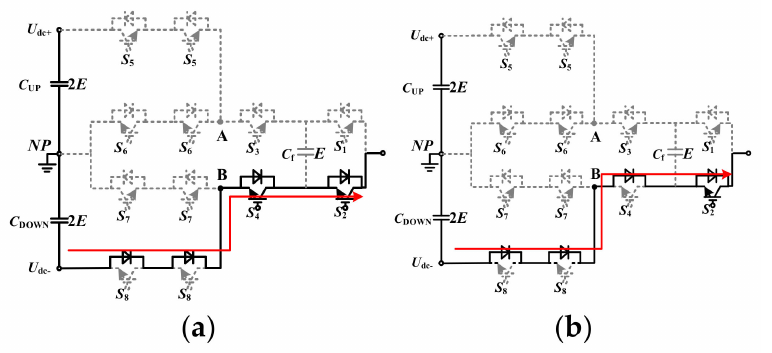
Figure 8. Conduction path of S3 and S4 equals to 0.1 or 0.0. ( a ) Positive current. ( b ) Negative